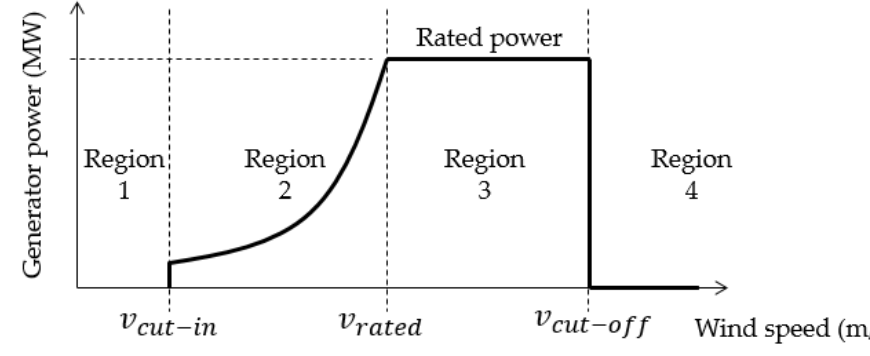
Figure 5. Typical power curve of a pitch-controlled wind turbine.